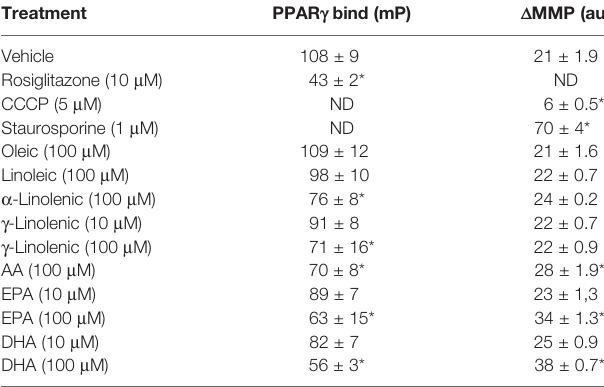
TABLE 1 | Effect of LCFAs on PPAR g ligand assay and mitochondrial membrane potential variation.